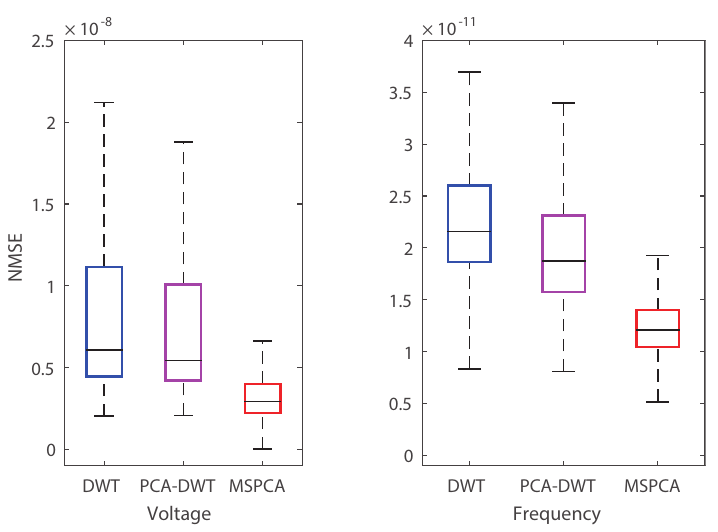
Figure 12. NMSE results for 24 h of PMU data.